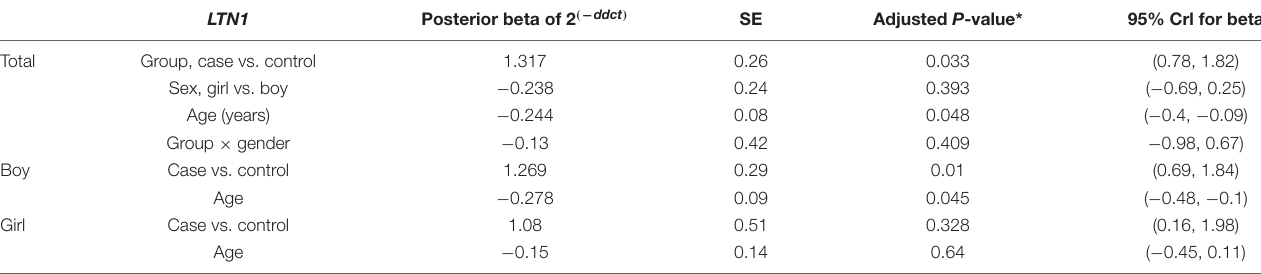
TABLE 4 | Relative levels of LTN1 in ASD cases and controls according to the Bayesian quantile regression model.